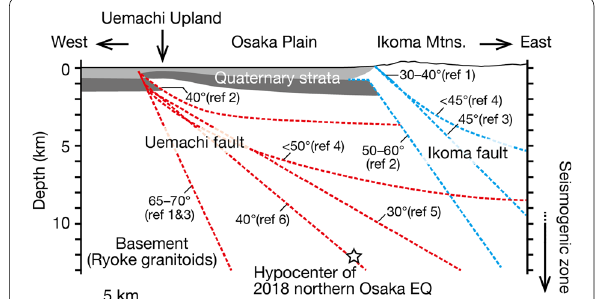
Fig. 2 Summary of the inferred geometries of the Uemachi and Ikoma faults in the Osaka Plain illustrated on a schematic geological cross section (modified partially from Ishiyama 2003). Here, references 1, 2, 3, 4, 5 and 6 correspond to Headquarters for Earthquake Research Promotion of MEXT (2001, 2004), Ishiyama (2003), Director General for Disaster Management (2006), Sato et al. (2009), Iwasaki (2016) and Kato and Ueda (2019), respectively. The hypocenter of the 2018 northern Osaka earthquake (EQ) proposed by Kato and Ueda (2019), located 12 km beneath the surface position 14 km east from the Uemachi fault, is indicated by a